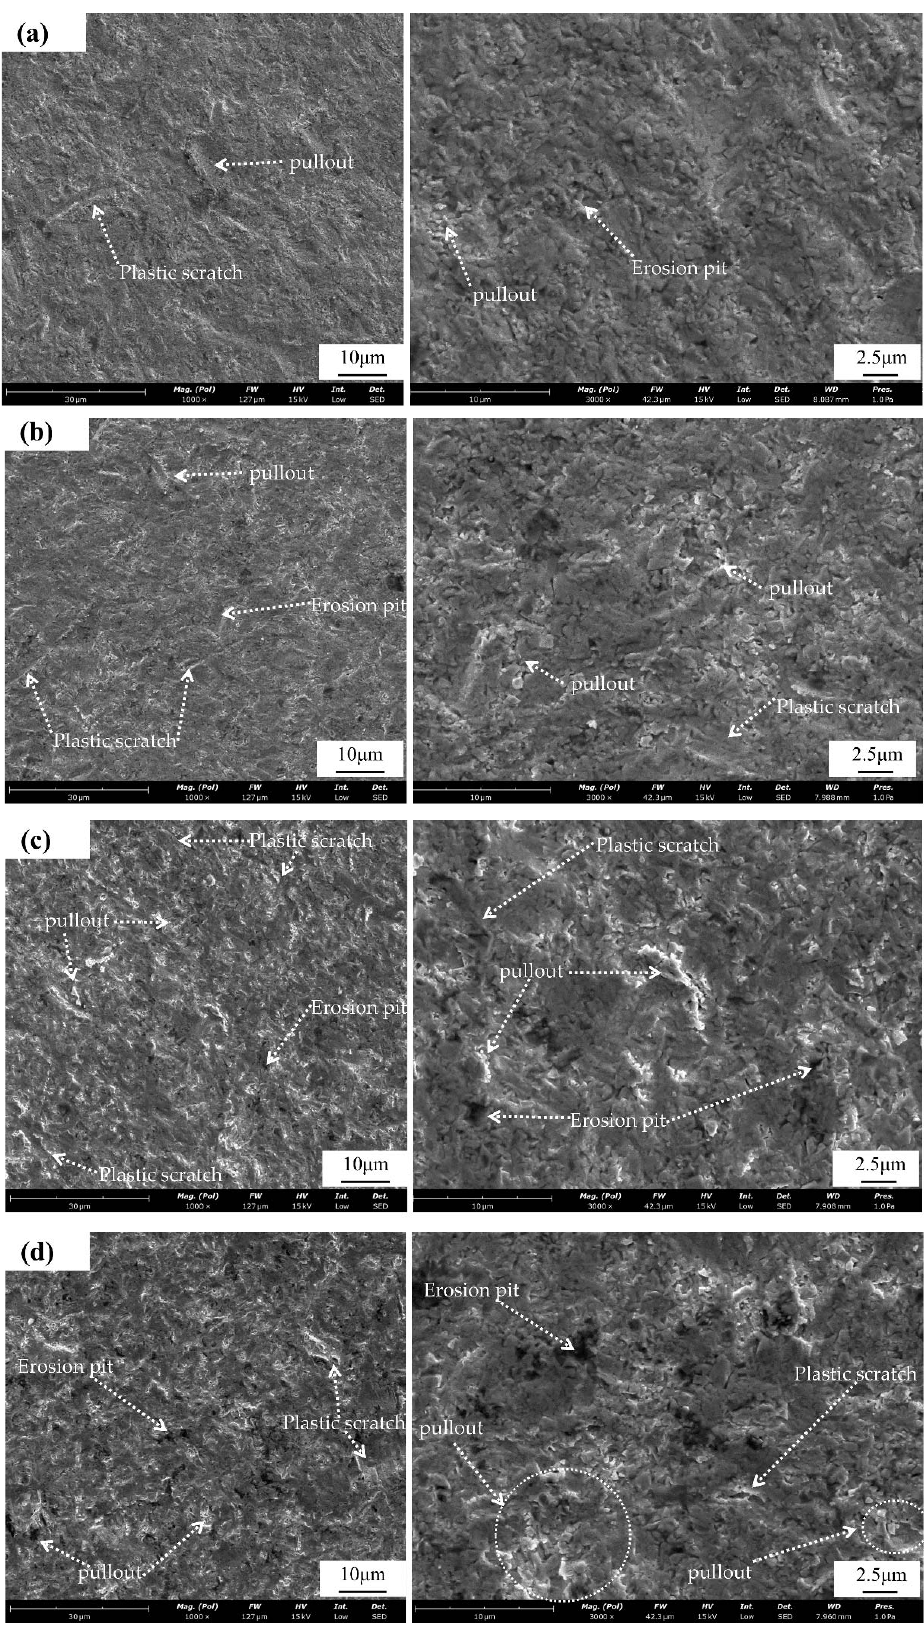
Figure 12. ( a ) Erosion of uncorroded SEM morphology sample; erosion of SEM morphology sample after ( b ) 12 h, ( c ) 24 h, and ( d ) 36 h of corrosion.